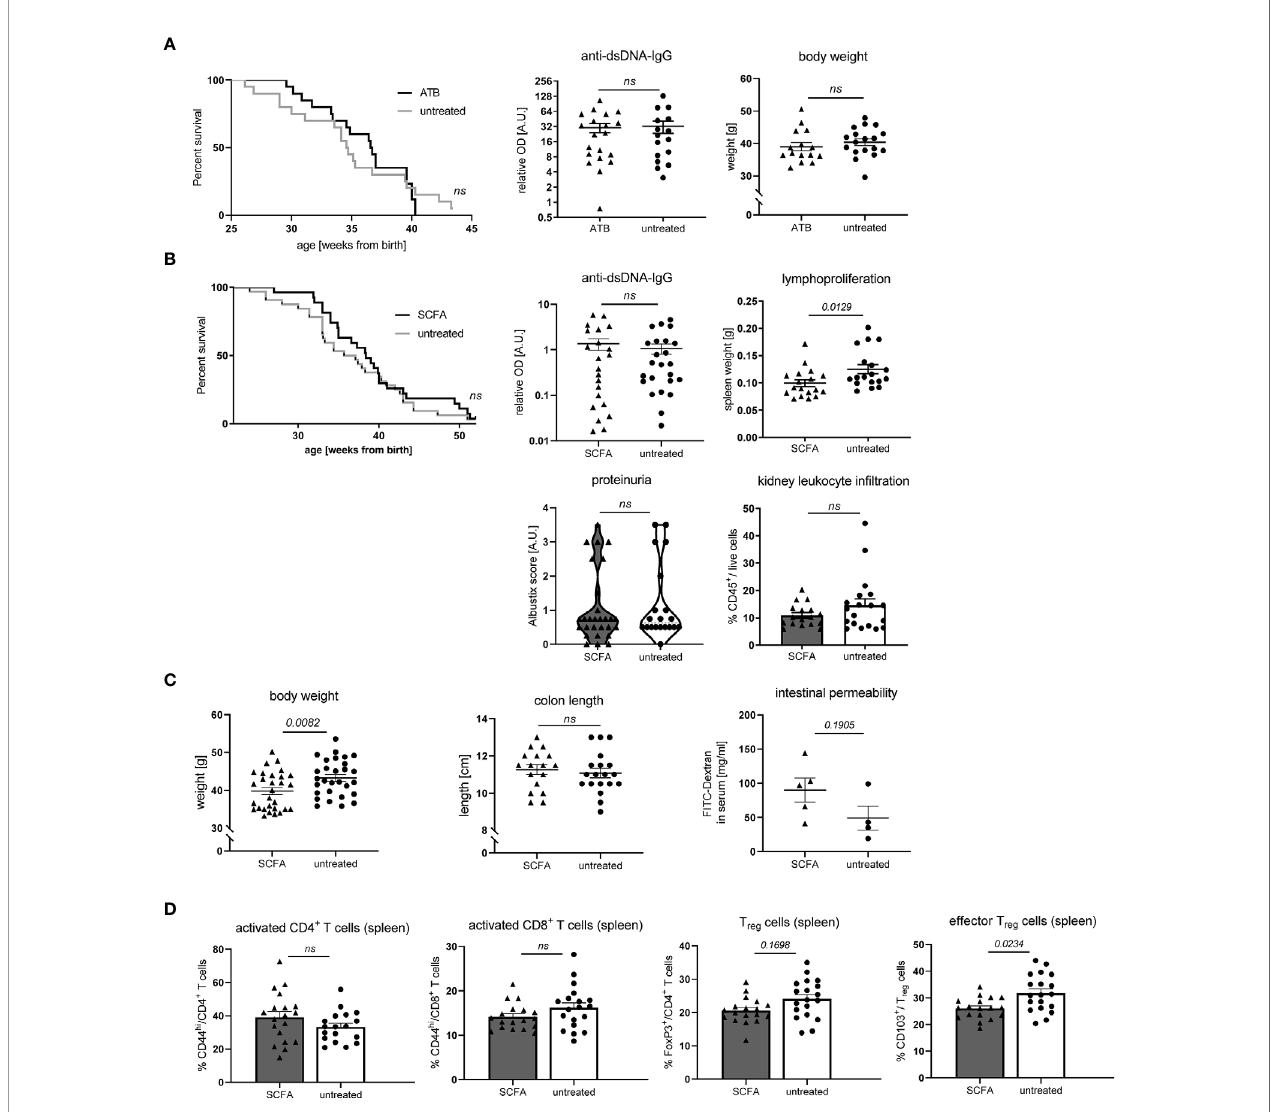
FIGURE 6 | Impact of SCFA application or microbiota suppression on disease development in NZB/WF1 animals. (A) Lupus-prone NZB/WF1 mice were administered antibiotics (ATB) in the drinking water (n = 15 – 20 mice) versus untreated drinking water (n = 18 – 20 mice). Overall survival as well as anti-dsDNA autoantibodies and body weight were determined at 28 w. (B – D) Lupus-prone NZB/WF1 mice received a SCFA-mix or untreated drinking water. (B) Overall survival (n SCFA = 27 mice, n untreated = 32 mice), anti-dsDNA autoantibodies, proteinuria and kidney in fi ltration by leukocytes, as well as spleen weights as sign of lymphoproliferation were determined at 28 w (n SCFA = 17 – 22 mice, n untreated = 18 – 24 mice). (C) Body weight (n SCFA=26-29 mice, n untreated = 29 mice), colon length (n SCFA = 18 mice, n untreated = 19 mice) as well as intestinal permeability with FITC-Dextran applied by oral gavage, were determined at 28 w (n SCFA = 5 mice, n untreated = 4 mice; representative of two independent experiments). (D) Broad immune status evaluation in spleen of 28 w old NZB/WF1 mice receiving a SCFA-mix (n = 18) or untreated drinking water (n = 19). Depicted are CD44 hi expression on CD4 + and CD8 + as marker of T cell activation as well as frequencies of FoxP3 + T reg and CD103 + FoxP3 + effector T reg . The Kaplan – Meier method was used for estimating OS in differently treated groups. All other results are expressed as scatter blots with mean ± SEM; each data point represents an individual mouse; p < 0.05 was considered signi fi cant, p > 0.2 is indicated as ns, not signi fi cant